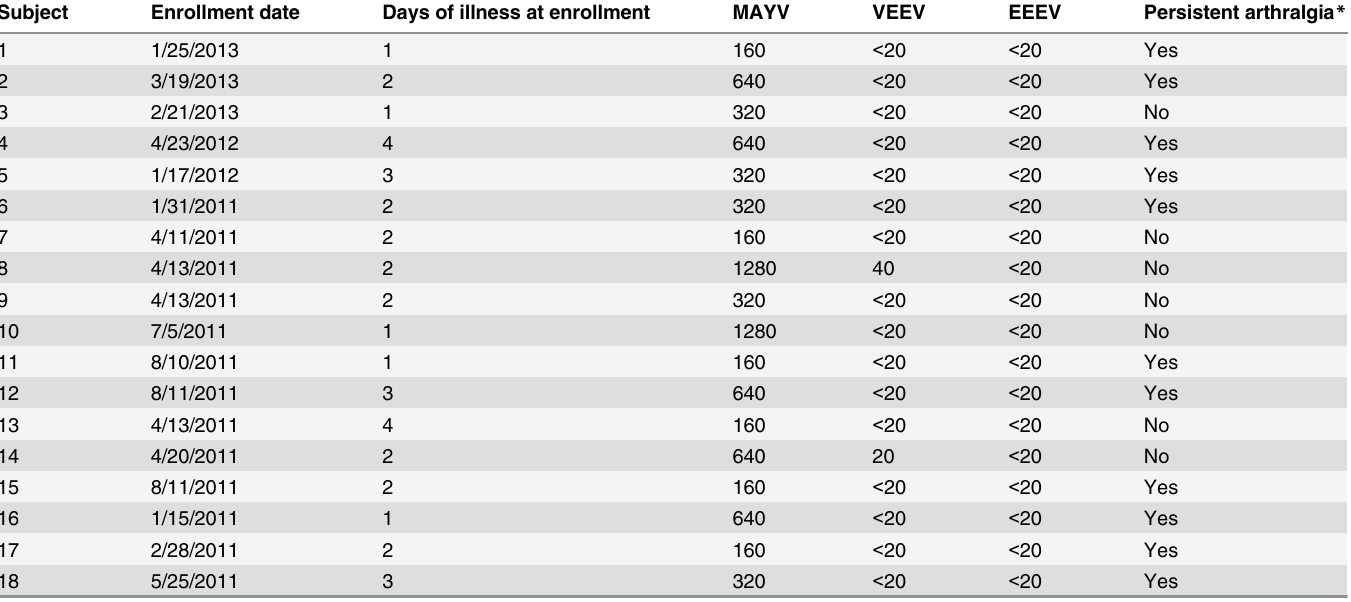
Table 1. Neutralizing antibody titers to alphaviruses and disease profile of study